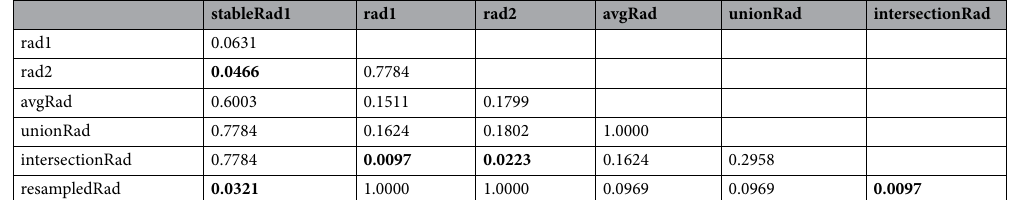
Table 2. p -value results with FDR correction for the statistical comparison of classifier performance on the resampledRad hold-out test set. p-values< 0.05 are highlighted in bold. The column and the row corresponding to resampledRad and stableRad1, respectively, have been removed due to not containing